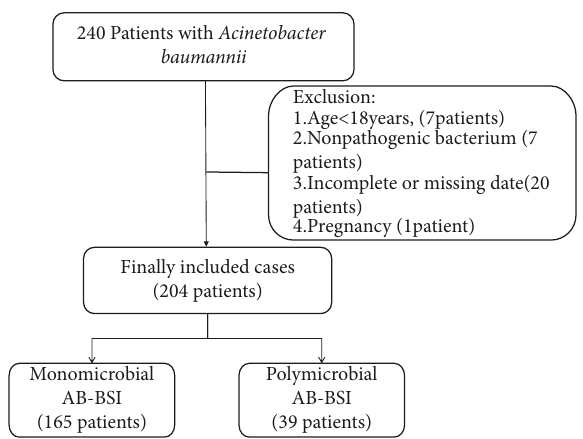
Figure 1: Flowchart of the study participant enrollment.